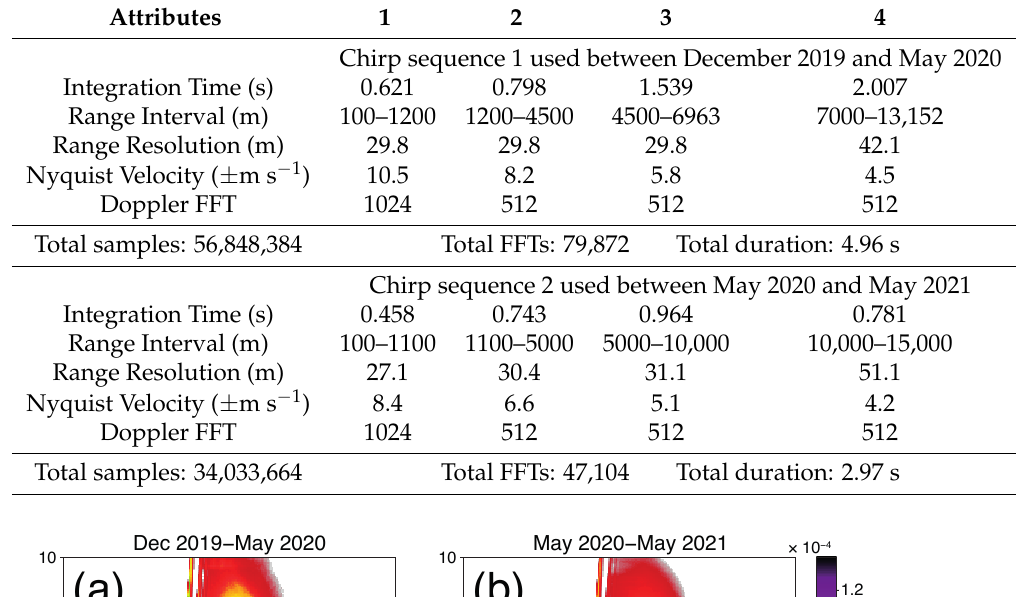
Table 2. MARS 94 GHz FMCW Doppler cloud radar chirp tables used between December 2019 and